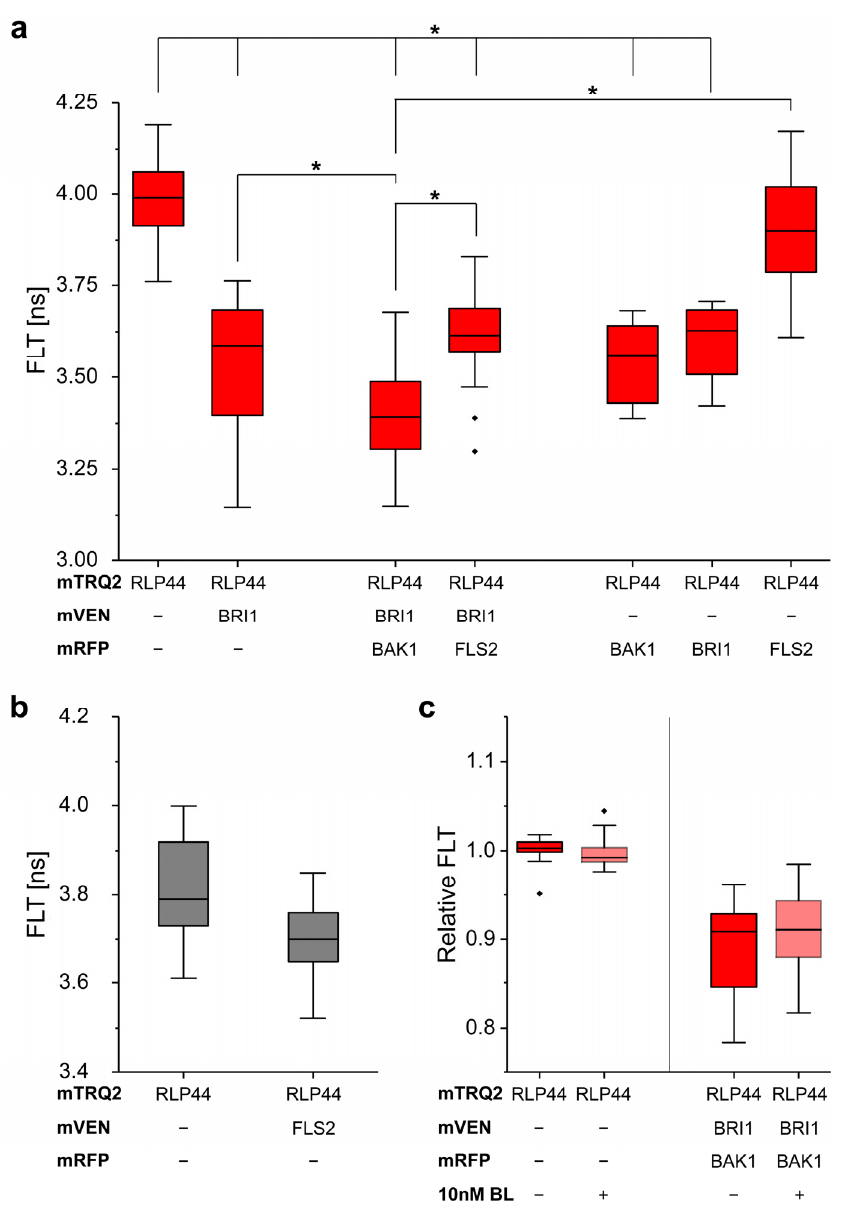
Figure 5. FRET-FLIM enables quantitative three-fluorophore protein-protein interaction and proximity analyses in N. benthamiana leaf cells. ( a ) Fluorescence lifetime (FLT) of RLP44-mTRQ2 after pulsed excitation of the cells with 440 nm light in the presence of the indicated mVEN and mRFP fusion proteins. ( b ) FLT of RLP44-mTRQ2 alone or in the presence of FLS2-mVEN. Data presentation as in ( a ). ( c ), Relative FLT of RLP44-mTRQ2 alone or in the presence of the indicated fusion proteins without (dark red) and with application of 10 nM brassinolide (BL) (light red). The average FLT of RLP44-mTRQ2 in the absence of BL was set to 1. The boxplots represent all data with the median as a solid black line within the box that is restricted by the first quartile (25%; lower end) and the third quartile (75%; upper end). Whiskers show the minimum and maximum value of the data, respectively, that are not defined as outlier (1.5 times interquartile range). Outliers are indicated as black diamonds. Statistical evaluations were performed by ANOVA followed by Tukey-Kramer HSD post hoc test. The black asterisk indicate statistically significant differences ( p ≤ 0.005).